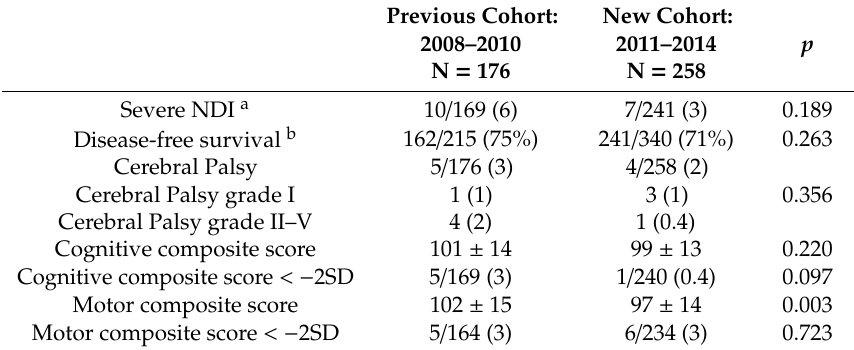
Table 2. Neurodevelopmental impairment in survivors included for